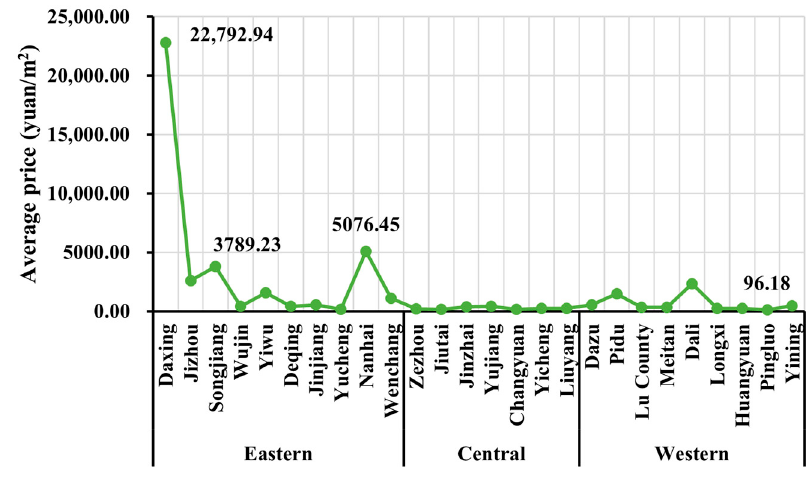
Figure 4. CCCL price movement in 26 pilot areas.